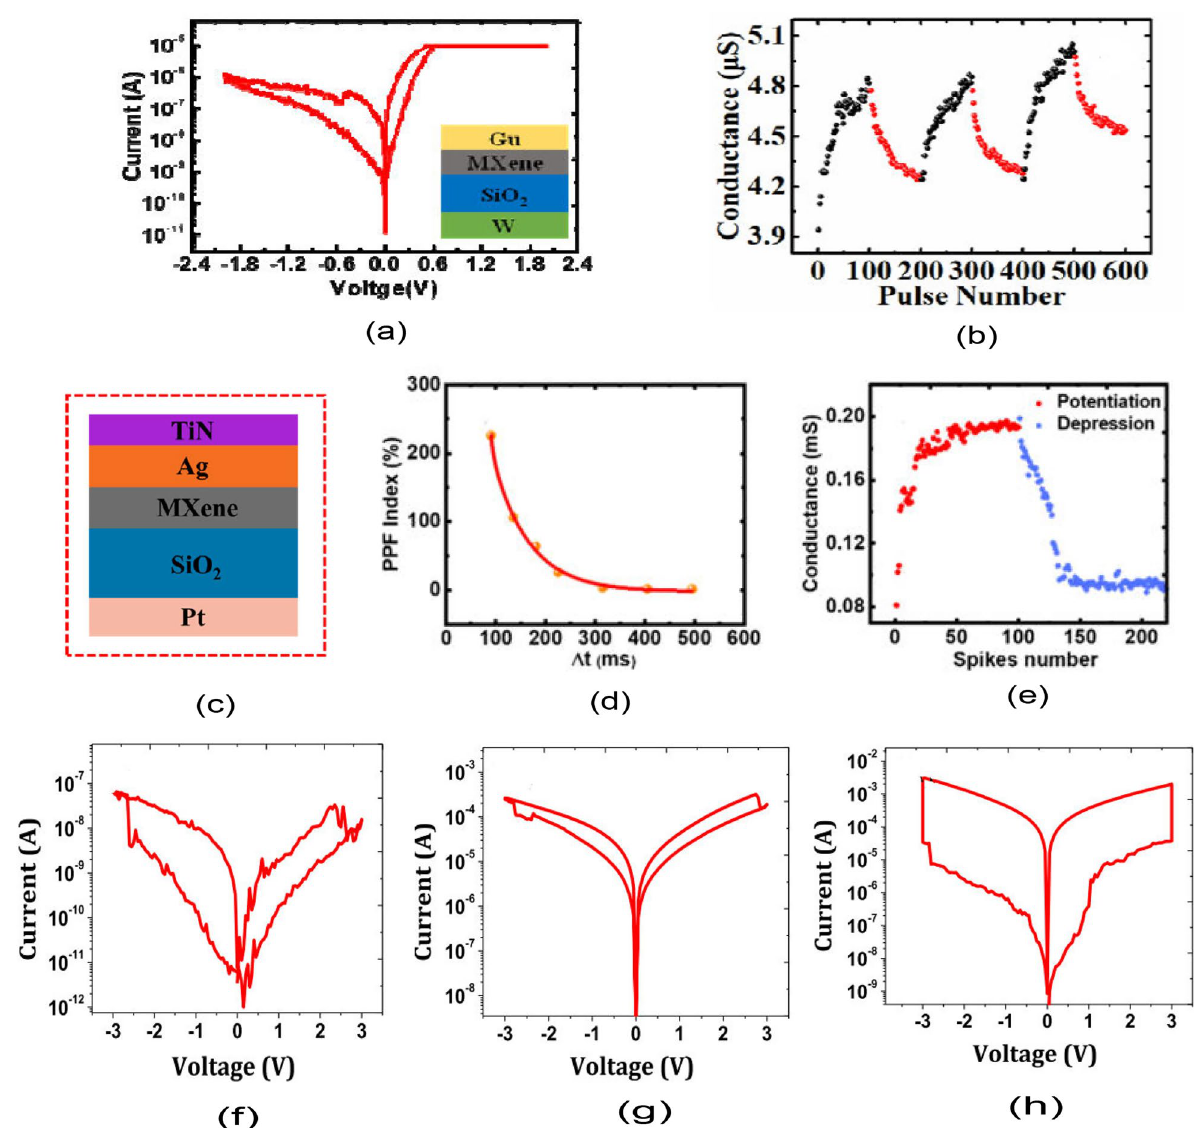
Fig. 22 Characteristics of the MXene 2D-based material used in RRAM devices. a , b Schematic of Cu/MXene/SiO2/W device with I–V charac- teristics (inset) and long-term potentiation (LTP) of Cu/MXene/SiO 2 /W RRAM device, respectively [266]. c , d and e Schematic of the TiN/Ag/ MXene/SiO2/Pt, paired-pulse facilitation (PPF) index relationship and potentiation–depression characteristics of Ag/MXene/SiO 2 /Pt RRAM device, respectively [265]. f , g and h Semi-logarithmic scales for Ag/Ti3C2/Pt, Pt/Ti3C2/Pt and Al/Ti 3 C 2 /Pt RRAM devices, respectively